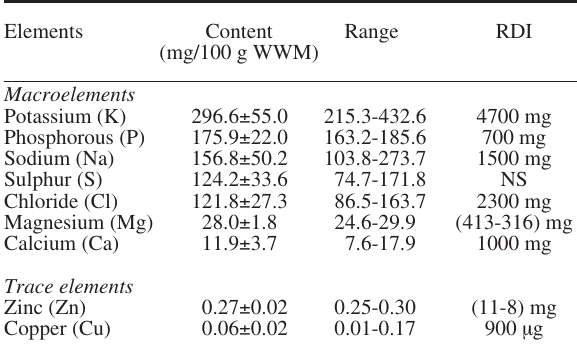
values in brackets for Mg and Zn refer to differences in genders: the first and second values correspond to male and female, respectively. Ns, has not been set. Table 4. – Main fatty acids (relative area percentage of total fatty acids) in lipids of black scabbardfish muscle, sFa (saturated